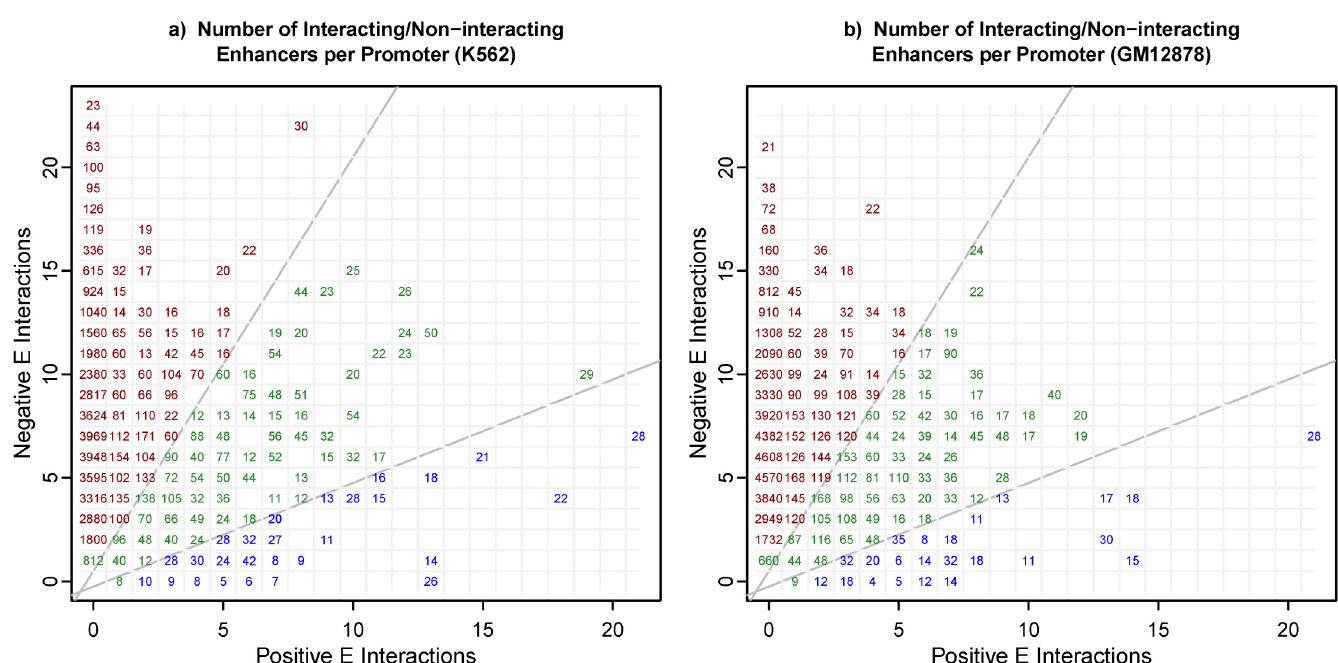
Fig 1. Most of the EP pairs used for training in Ref. 1 share promoters and promoter features with multiple EP pairs. a) For cell line K562, and b) for cell line GM12878, for each promoter we show the number of positive and negative EP pairs sharing a promoter. In a) for example, there are 27 interactions in position (7,2), which means three distinct promoters each interact positively with 7 enhancers and negatively with two enhancers in the training data. When the number of negative and positive EP pairs interacting with a promoter are imbalanced, they can be predicted correctly from training set promoter features. The blue interactions have a 2-fold or greater imbalance (pos > neg) and the red interactions have a 2-fold or greater imbalance (neg > pos), and both red and blue interactions (92% of the data) can lead to test set contamination by shared promoter features.